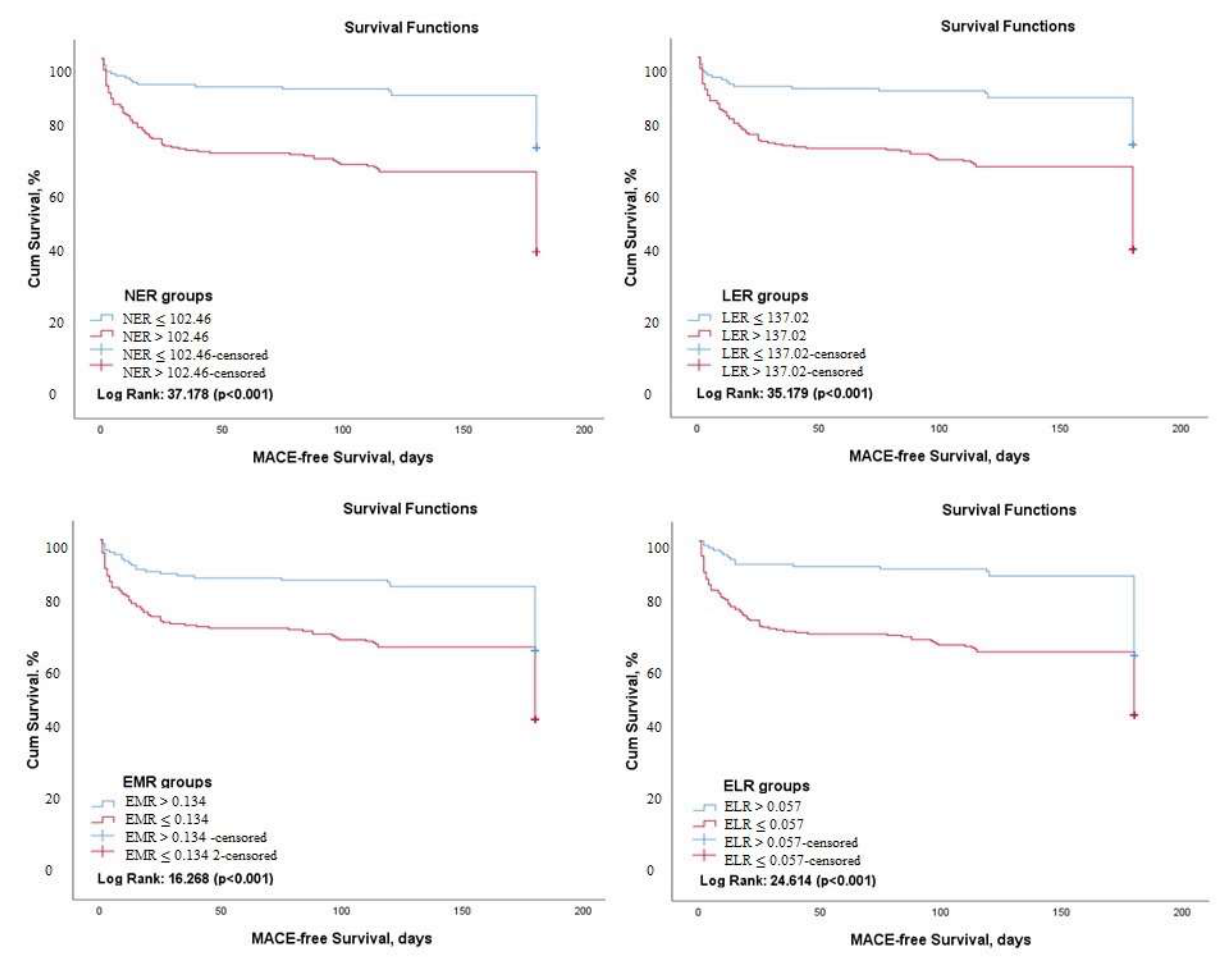
Figure 2. Kaplan–Meier survival analysis demonstrating 6-month MACE-free survival according to NER, LER, EMR, and ELR (NER: Neutrophil-to-Eosinophil ratio, LER: Leukocyte-to-Eosinophil Ratio, EMR: Eosinophil-to-Monocyte Ratio, ELR: Eosinophil-to-Lymphocyte ratio). Multivariable cox regression revealed that NT-pro BNP (OR: 1.682, 95% CI: 1.106–2.312, p = 0.001), Na + (OR: 0.932, 95% CI: 0.897–0.969, p < 0.001), NER (OR: 2.740, 95 % CI: 1.797–4.177, p < 0.001), LER (OR: 2.705, 95% CI: 1.752–4.176, p < 0.001), EMR (OR:1.654,